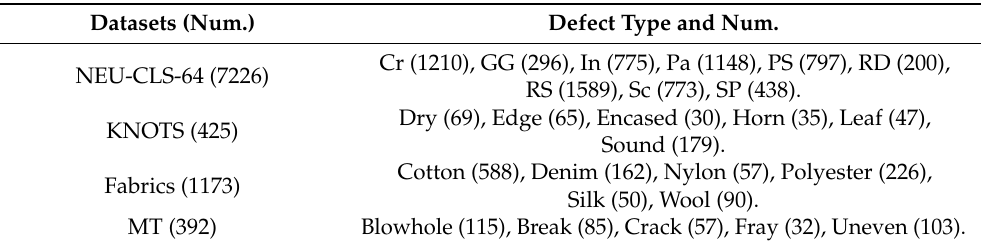
Table 1. Details of four defect datasets.